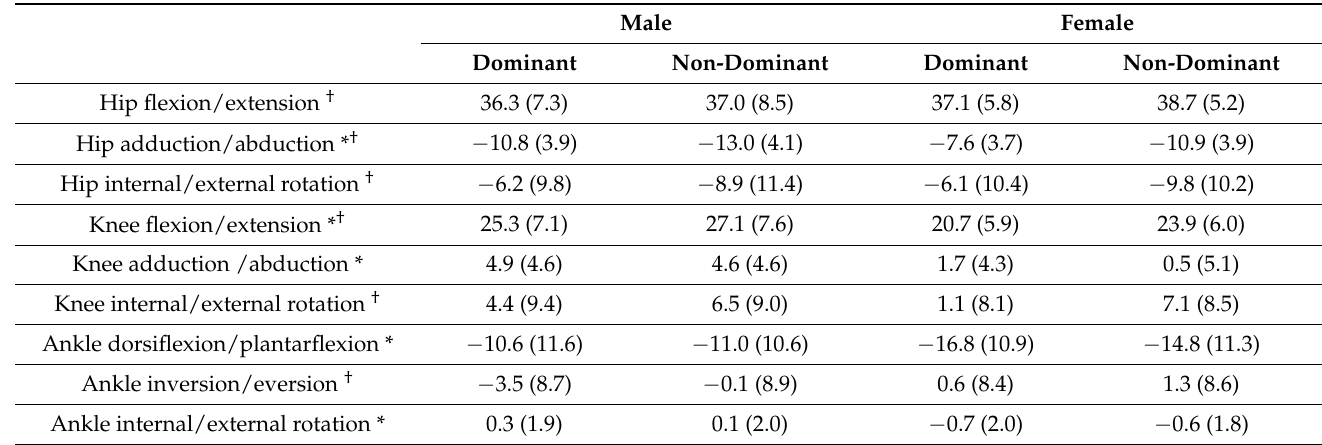
Table 3. Lower extremity angles at initial contact.